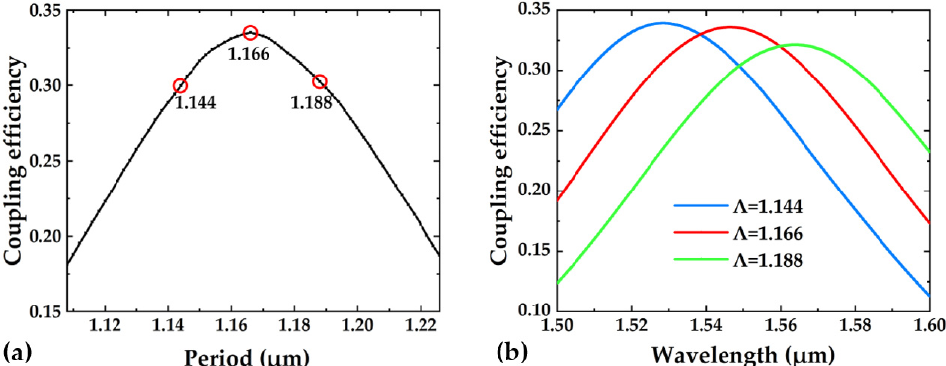
Figure 3. ( a ) Coupling efficiency as a function of the period. ( b ) Coupling efficiency as a function of the wavelength at different periods.